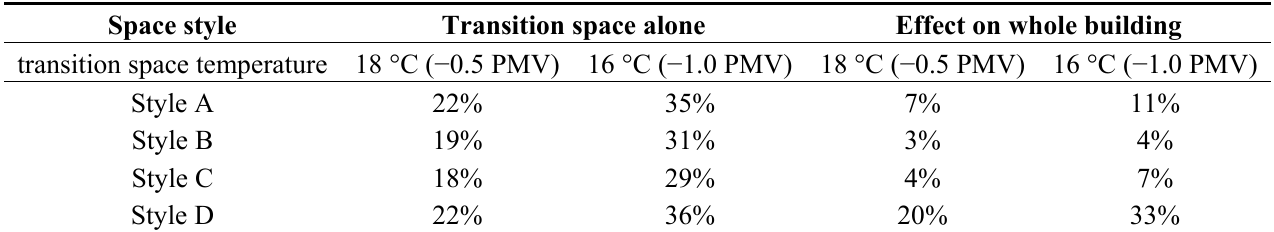
Table 7. Reductions in annual heating energy use for transition zone study (data adapted from [21]).